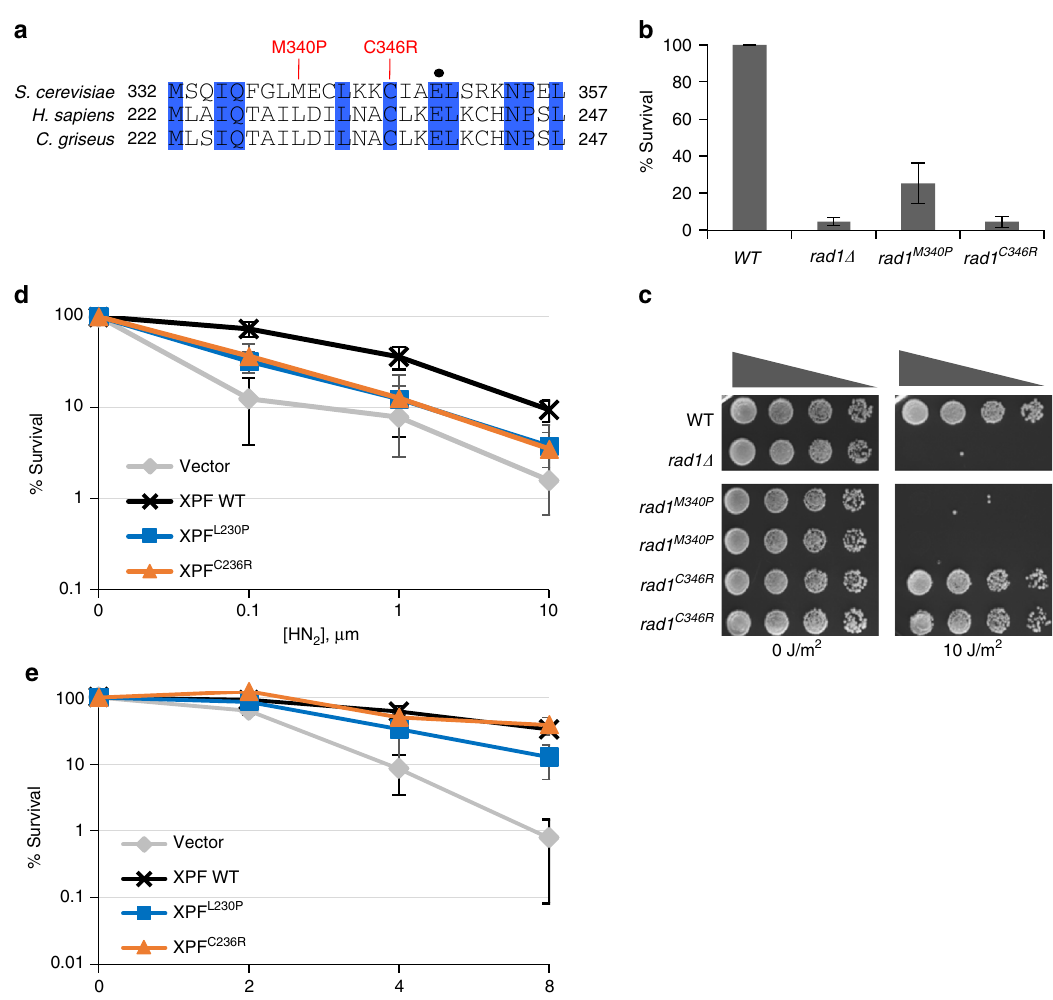
Fig. 7 XPF mutations that result in Fanconi anemia or combined Fanconi anemia/Cockayne Syndrome are de fi cient in 3 ′ fl ap removal. a FA causing XPF mutations are located near XPF-E239. Conserved residues are highlighted in blue. Mutations analogous to human mutations that result in Fanconi anemia or Fanconi anemia/Cockayne Syndrome are indicated. Rad1-E349 is indicated by a black dot. b The effect of FA-causing rad1 mutations on single-strand annealing. c Serial dilutions of rad1 mutants analogous to FA-causing XPF mutants after UV (10 J/m 2 ) treatment. d , e Percentage of survival of FA causing XPF mutants after treatment of different doses of HN 2 ( d ) and UV ( e